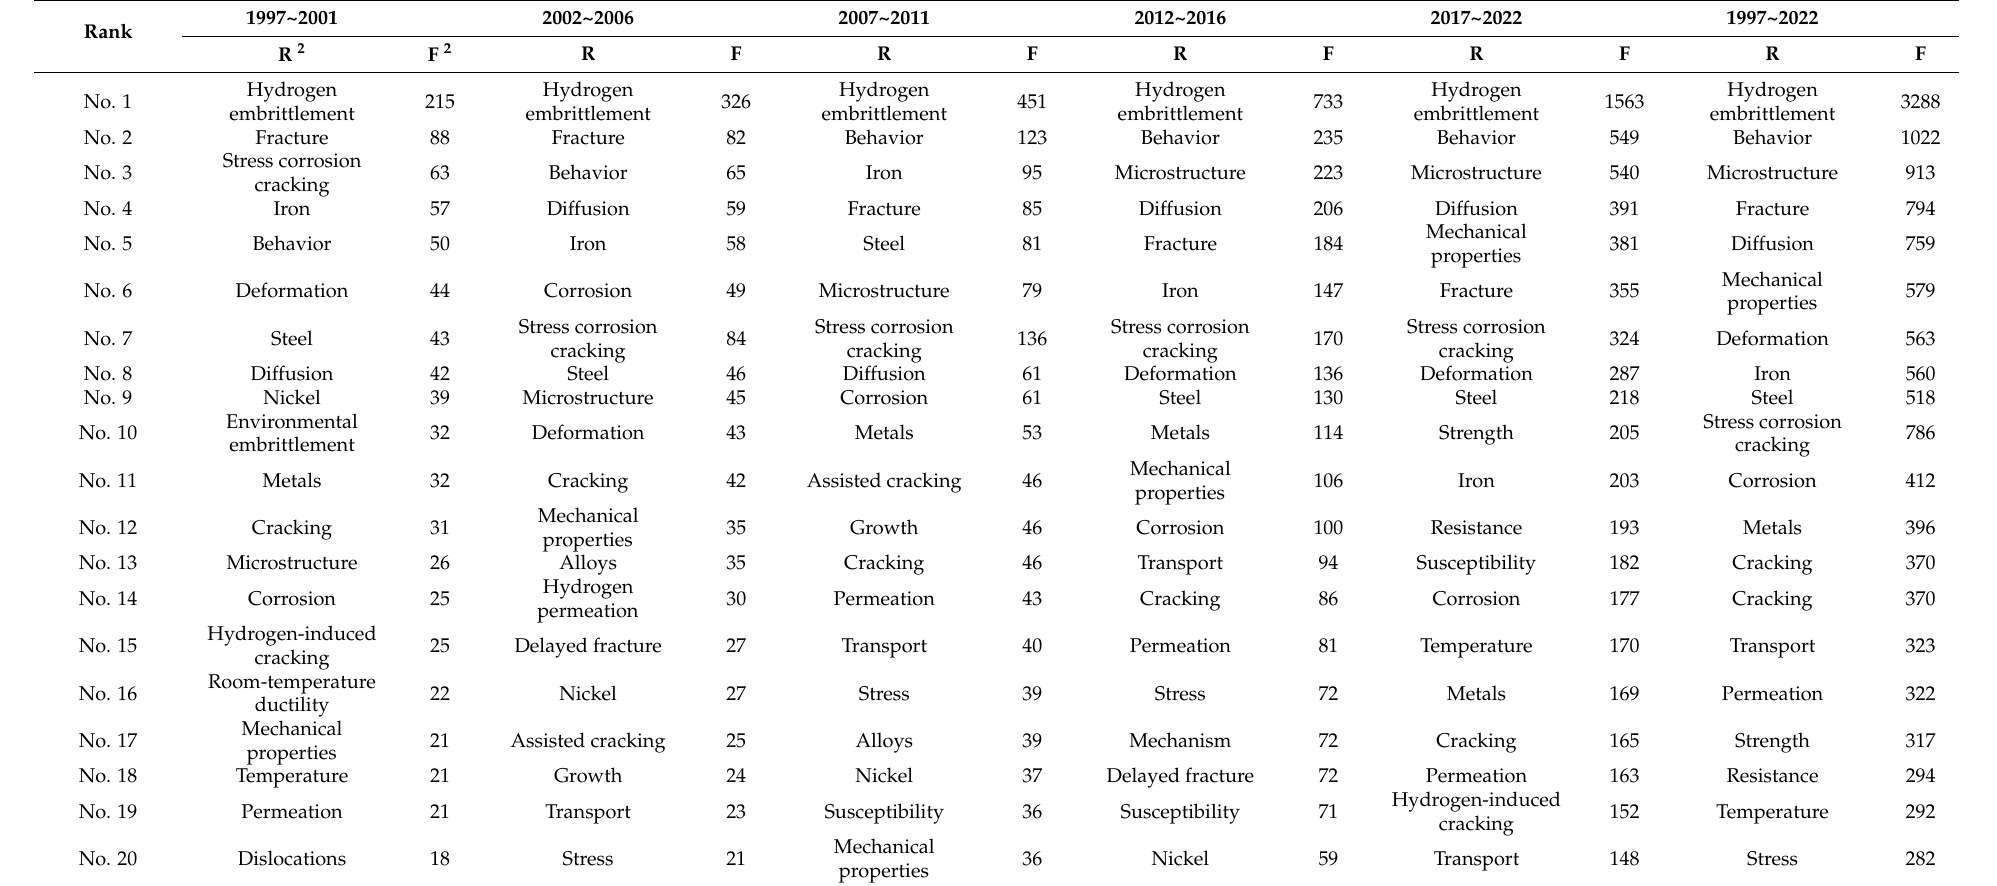
Table 7. Distribution of top 20 research hotspots for work on hydrogen embrittlement during different